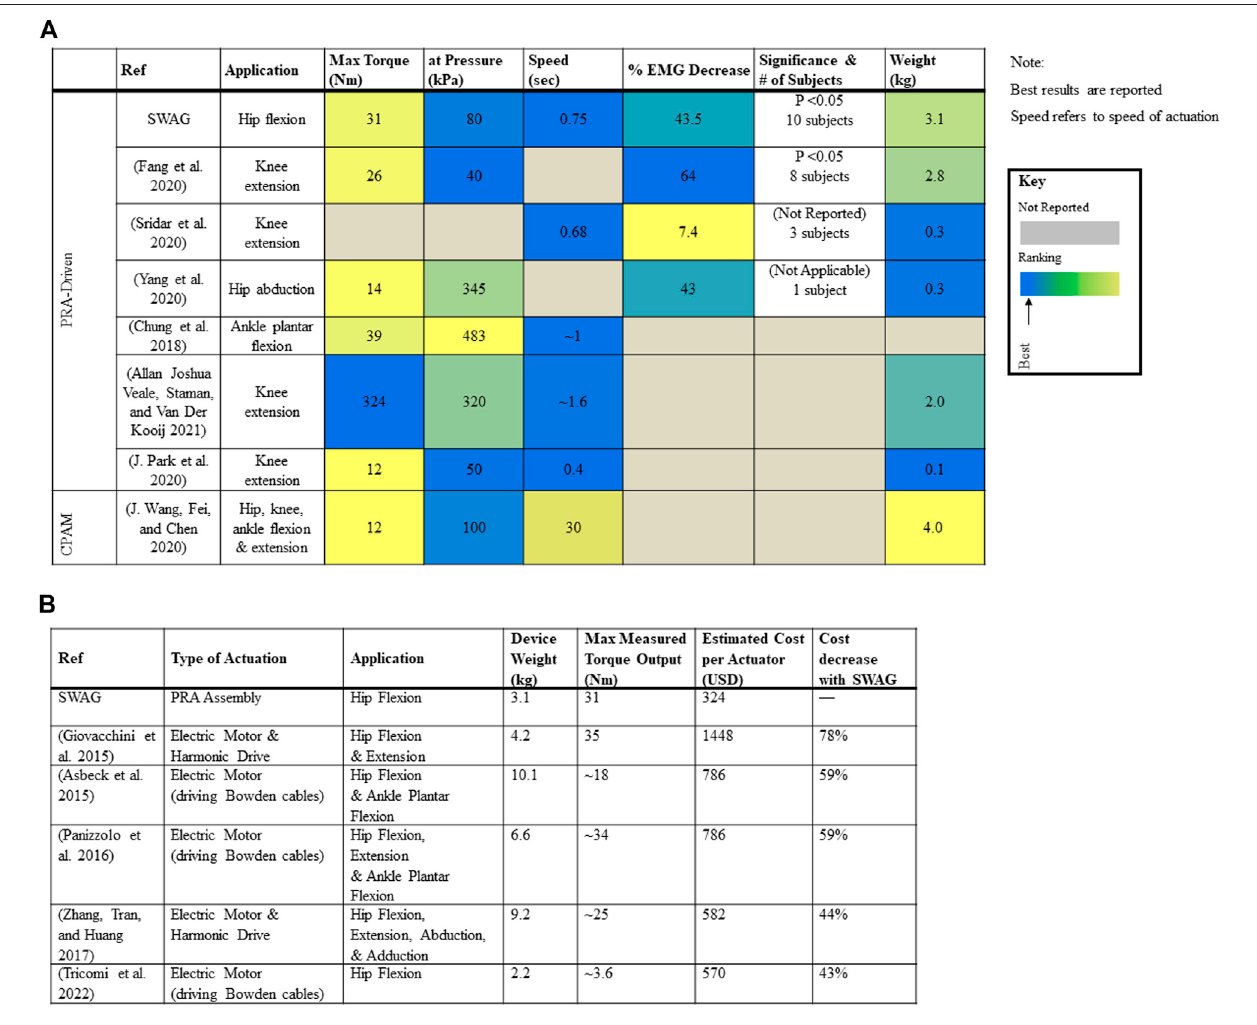
FIGURE 12 | Comparison of SWAG with other devices: (A) Comparison with Contemporary Lower Limb Devices Driven by Soft Bending Actuators. (B) Comparison with Contemporary Hip Devices Driven by Electric Motor Actuation.